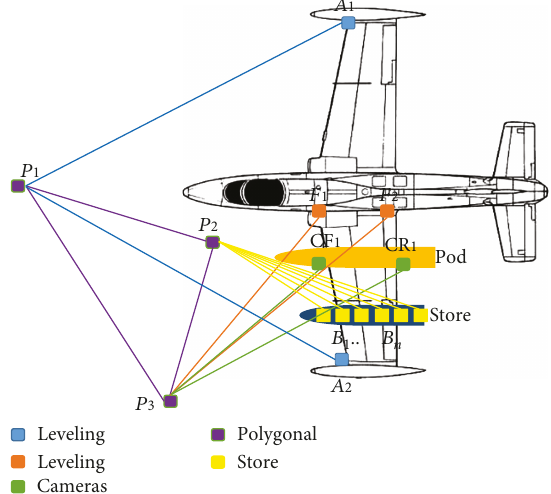
, P P 1 2 , and 3 ) to measure the